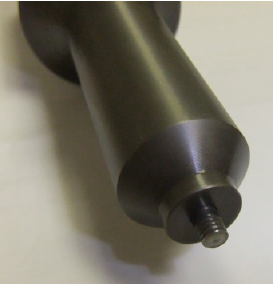
Figure 2: Retractable tool shoulder (10mm) and pin. Figure 3: Al 6082-T6 FS welded tubular